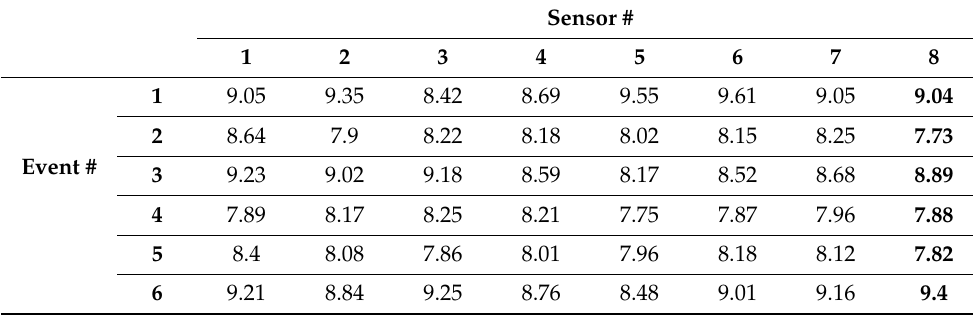
Table 2. Calculated total moments (A m 2 ) using the MOGA method.